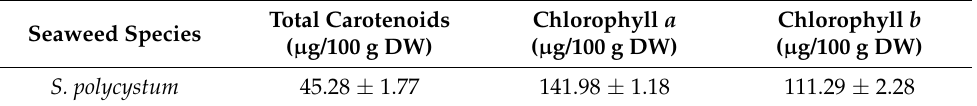
Table 2. Content of total carotenoids, chlorophyll a and chlorophyll b in extracts of s elected seaweed species sampled in the Malaysian Peninsular.